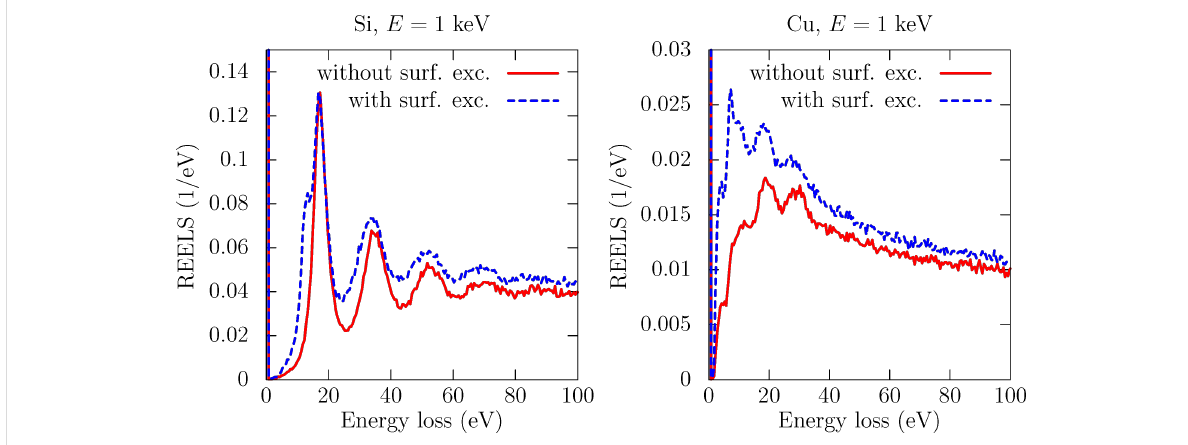
Figure 2: Comparison of reflection-electron-energy-loss spectra (REELS) of Si (left) and Cu (right) under bombardment with 1-keV electrons at normal incidence, without (red solid curves) and with (blue dashed curves) an account of surface excitations. All backscattered electrons are collected.